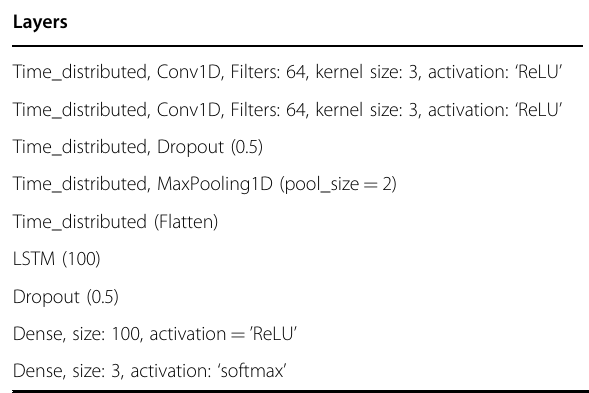
Table 2 Deep neural network